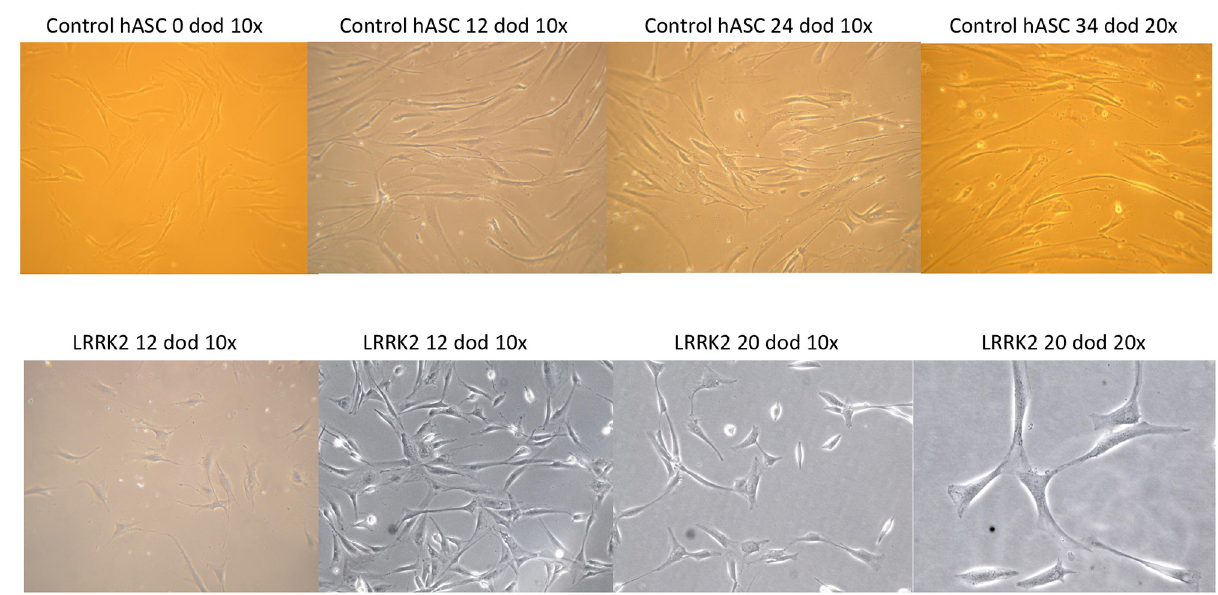
Fig 2. Representative images of hASC. Forearm human adipose stem cells from control and PD-diagnosed lines (upper and lower panels, respectively) over time up to 20 days of differentiation.